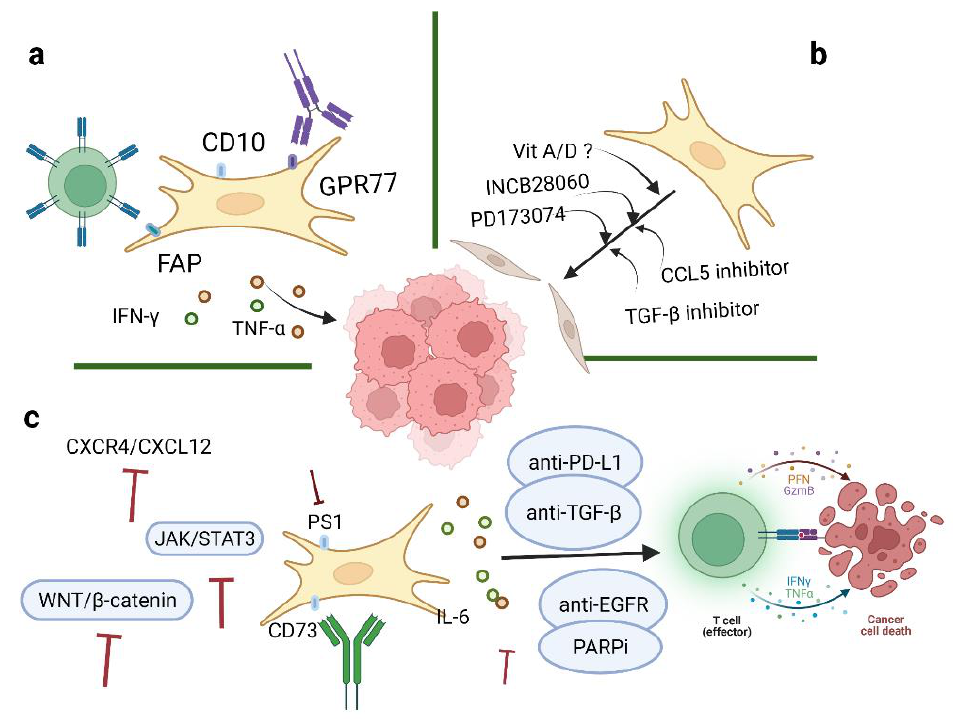
Figure 4. Therapeutic strategies of CAFs in ovarian cancer. Three aspects of strategies targeting CAFs in TME include: ( a ) Depletion of CAFs via specific surface markers; ( b ) conversion of activated CAFs to the quiescent state by inhibitors; and ( c ) targeting significant downstream effectors of CAFs. Image created with BioRender.com (accessed on 23 May 2022). CAFs: cancer-associated fibroblasts; TME: tumor microenvironment. Table 2. CAFs-associated inhibitors in ovarian